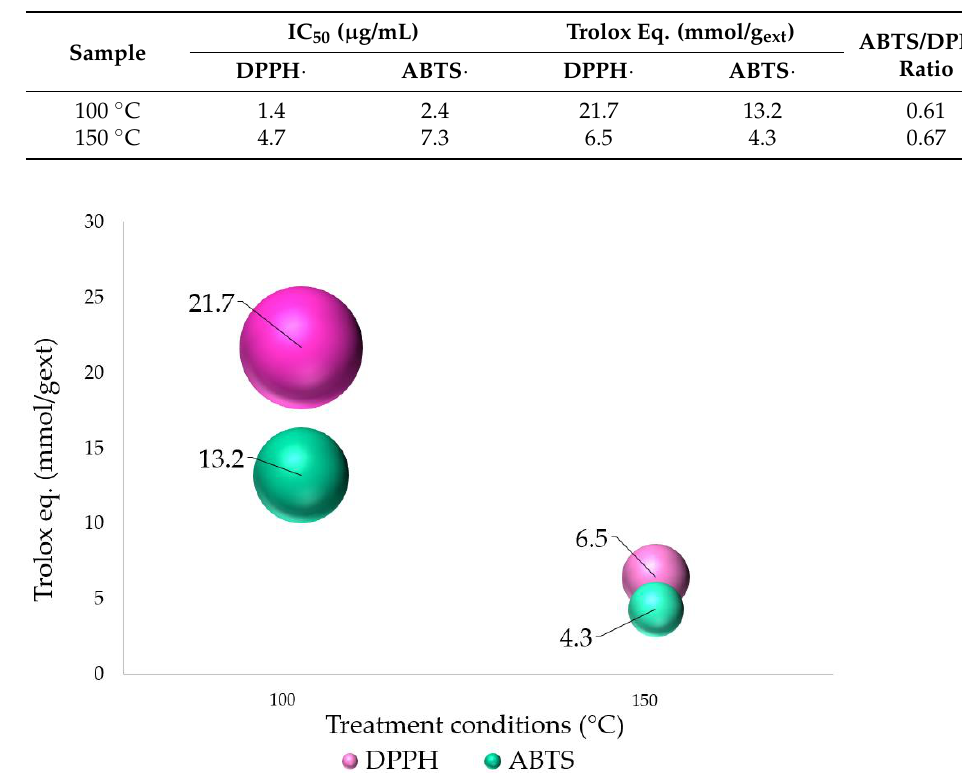
Table 6. Evaluation of the antioxidant activity, with DPPH · and ABTS · assays.